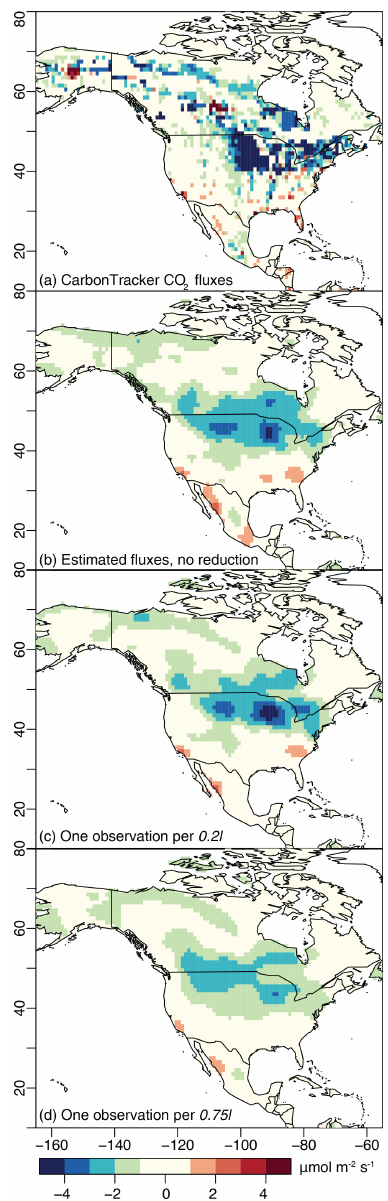
Figure 3. CO 2 fluxes estimated for the summer 2015 synthetic case study, averaged across the 6-week study window: (a) the syn- thetic CO 2 fluxes from NOAA’s CarbonTracker estimate, (b) fluxes estimated from XCO 2 data with no reduction (6799 data points), (c) fluxes estimated from data reduced to one point per 0 . 2 l (2263 data points), and (d) fluxes estimated from data reduced to one point per 0 . 75 l (755 data points). The estimate with no reduction (b) and a reduction of 0 . 2 l (c) reproduce broad, continental-scale spatial patterns in the synthetic fluxes (a) , while the estimate with 0 . 75 l re- duction has lost spatial definition. Note that the inverse model here uses a non-informative prior, so any patterns in the flux estimates are informed by the observations and not by any prior flux informa-